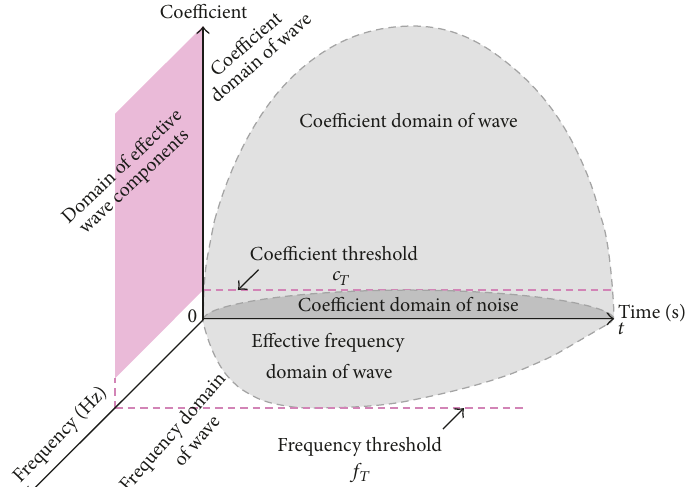
Figure 1: Schematic of the analytical model of the scale-changed domain decomposition analysis. The time domain is determined by the time duration; the thresholds in the frequency domain and the wavelet coefficient domain are restricted by the effective wave component and the peak noise coefficient,